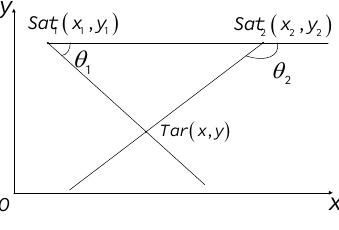
Figure 4. Dual-satellite